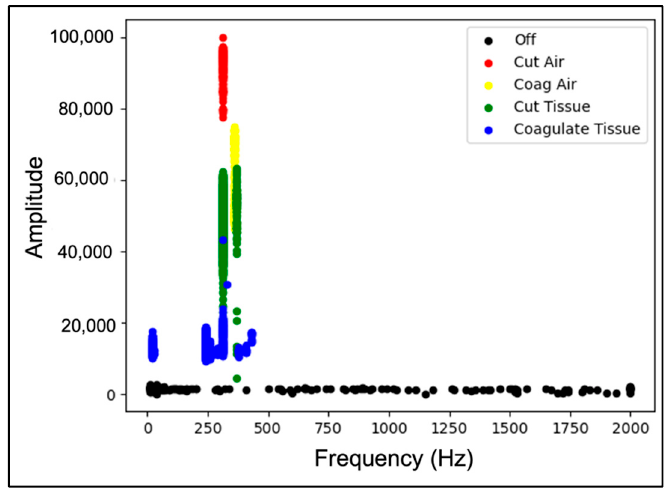
Figure 9. SVM features used to separate cautery signal for collection with Valley Lab cautery device set to 40 W power excising bovine tissue.